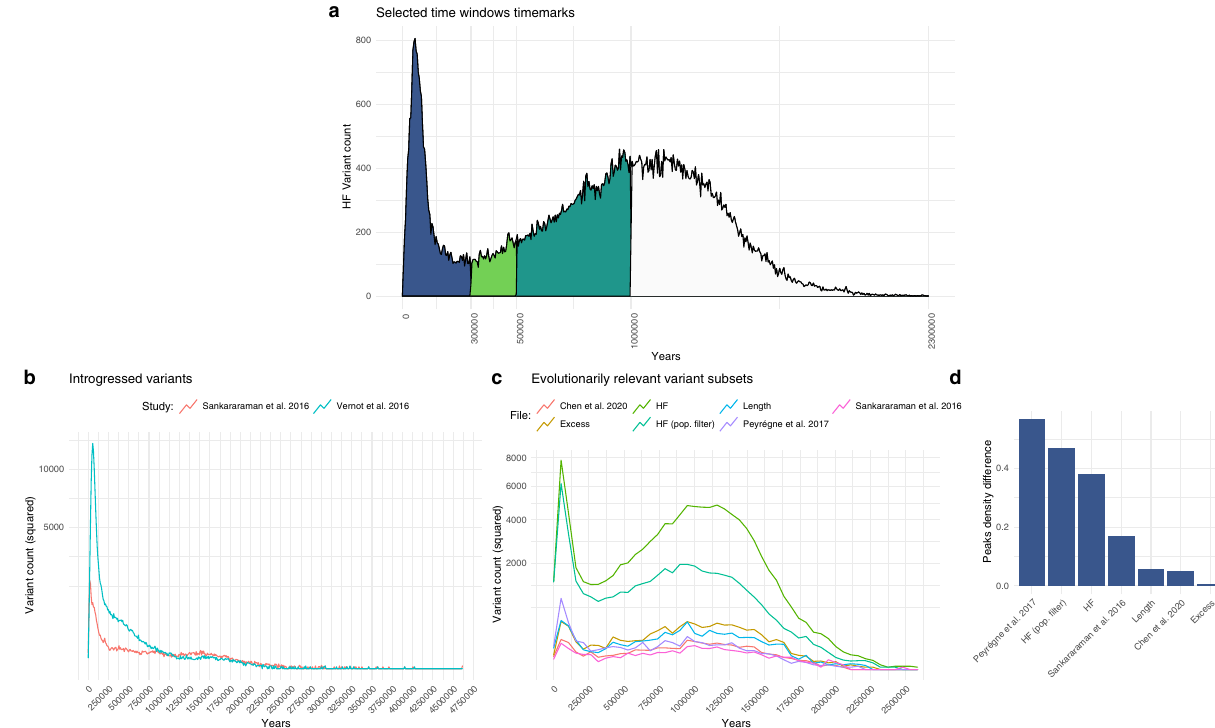
Figure 2. ( a ) Selected temporal windows used in our study to further interrogate the nature and distribution of HF variants. ( b ) Distribution of introgressed alleles over time, as identified by 27,30 . ( c ) Plots of HF variants in datasets relevant to human evolution, including regions under positive selection 29 , regions depleted of archaic introgression 27,28 and genes showing an excess of HF variants (‘excess’ and ‘length’) 19 . Variant counts in ( a , c , d ) are squared to aid visualization. ( d ) Kernel density difference between the highest point in the distributions of ( d ) (leftmost peak) and the second, older highest density peak, normalized, in percentage